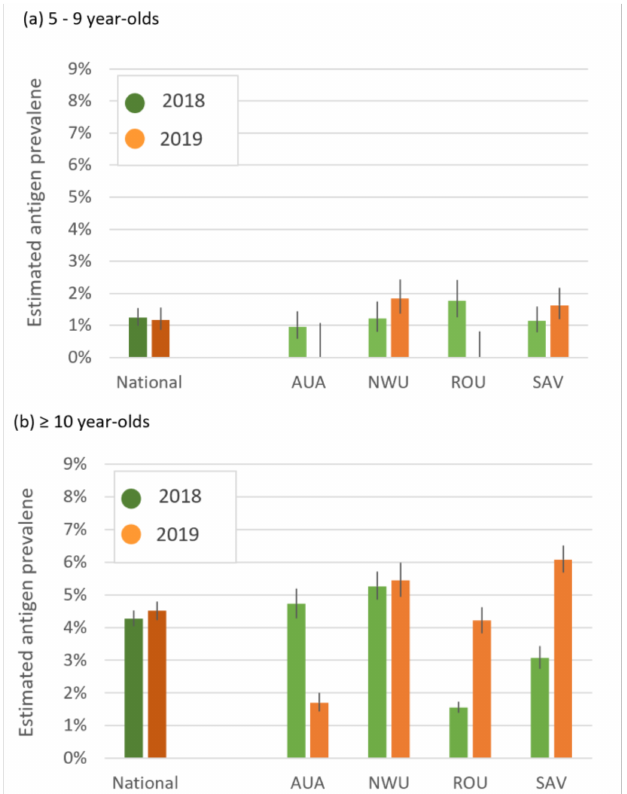
Figure 5. Adjusted antigen prevalence from human survey in 2018 and 2019 for 30 randomly selected primary sampling units (PSUs) in Samoa for ( a ) 5–9 year-olds and ( b ) ≥ 10 year-olds. Adjusted for selection probability at PSU and individual levels, clustering at the PSU level, finite population correction, and standardized for age and